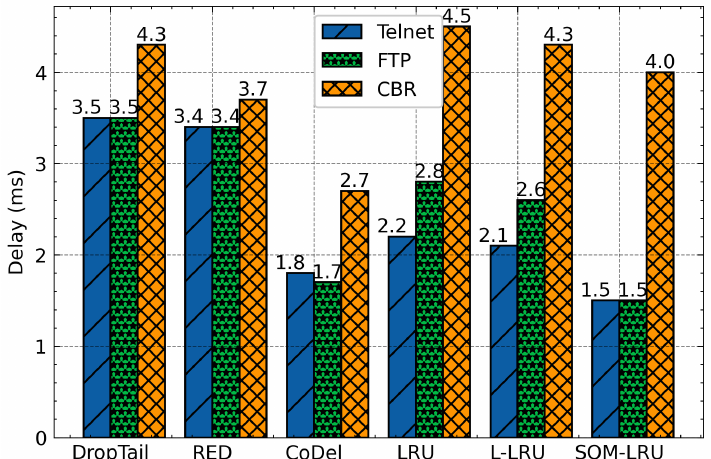
Figure 10. Average delay comparison.